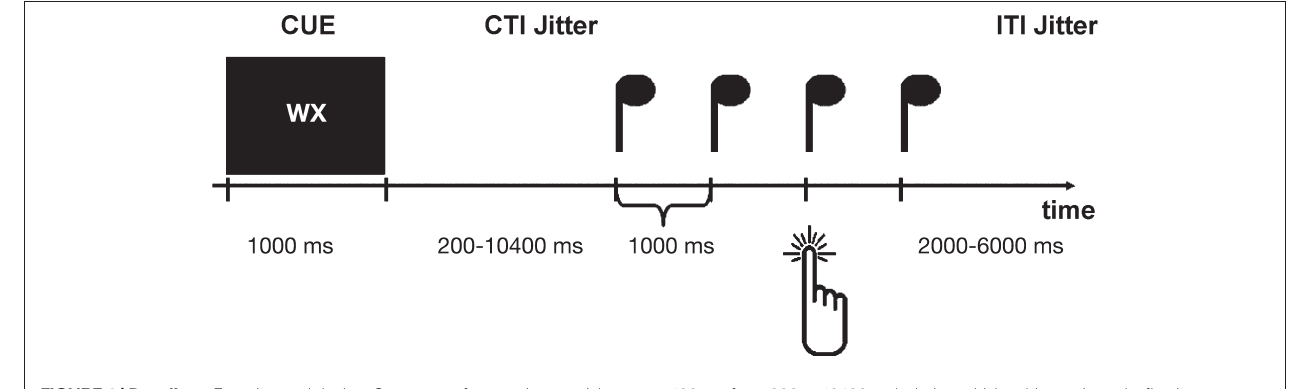
FIGURE 1 | Paradigm. Experimental design. Sequence of events in one trial. For details see text. First, subjects are presented with a cue indicating an internal or an external what (left or right key press) or when decision (third or fourth tone). In the example subjects could freely select which button to press, and when. After a variable CTI (jittered in a pseudo-logarithmic order in steps of